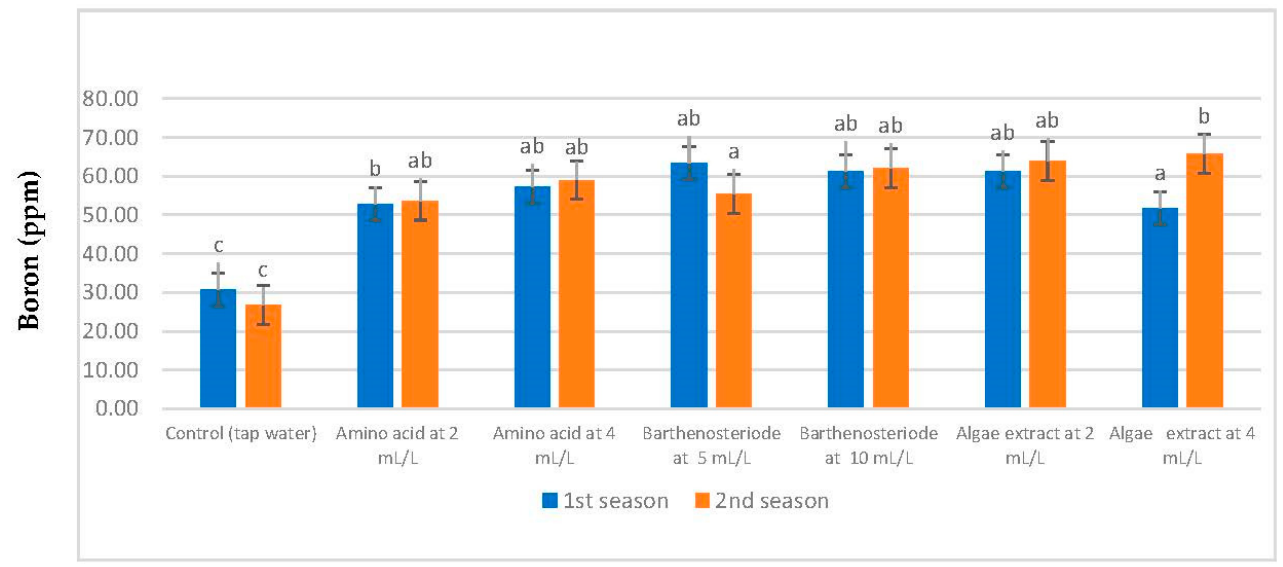
Figure 9. Effect of various bio-stimulants treatments on boron (ppm) of chia ( Salvia hispanica L.) plants during the 2019–2020 and 2020–2021 seasons. For the same column, means followed by the same letter are not statistically different, according to the Tukey multiple range test.